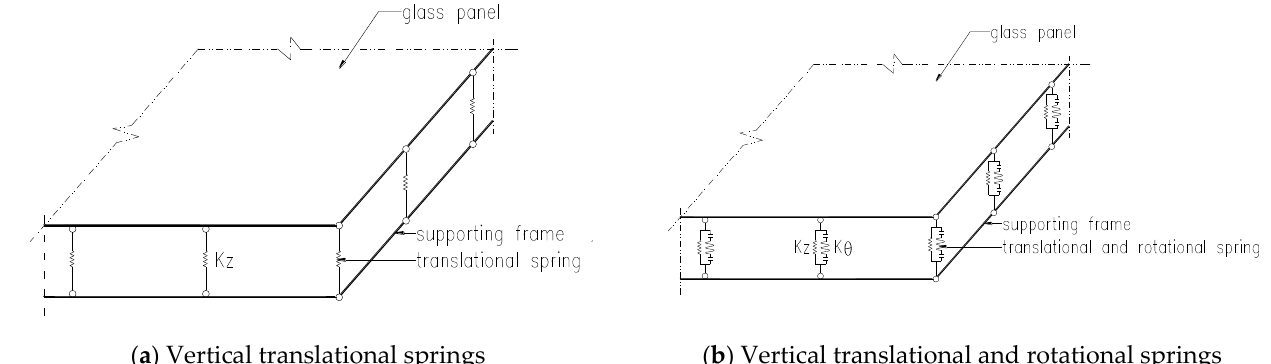
Figure 7. Boundary section diagram.